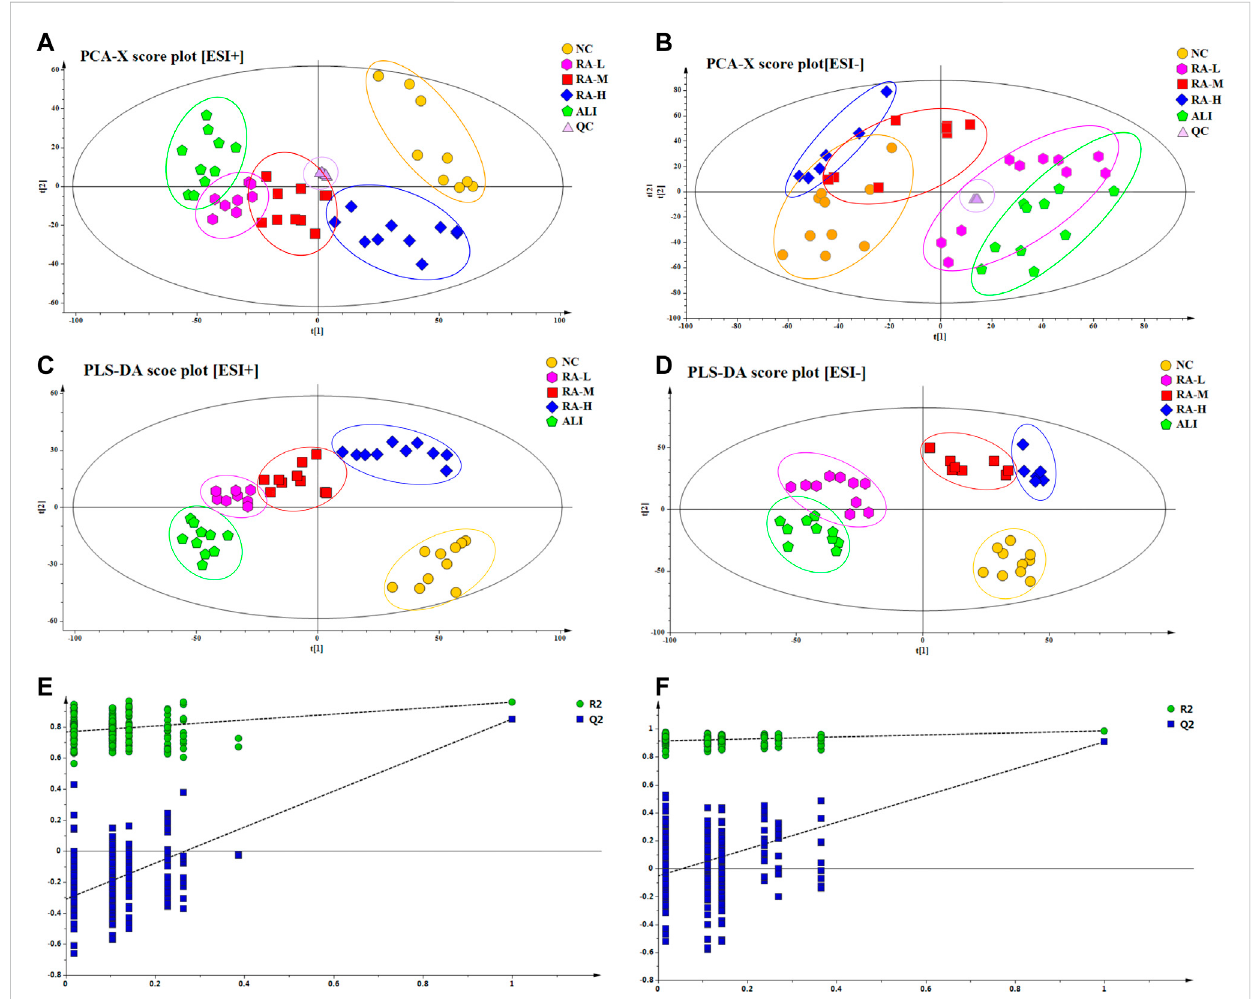
PCA score plots and PLS-DA score plots of different groups in ESI+ and ESI- mode respectively. The score plots of PCA of NC, ALI, RA-L, RA-M and RA-HgroupsfromPCAanalysisinESI+ (A) andESI- (B) ;Thescore plots ofPLS-DA ofNC,ALI,RA-L,RA-Mand RA-HgroupsfromPLS-DAanalysisinESI+ (C) and ESI- (D) ; 200-permutation test of PLS-DA model in ESI+ (E) and ESI- (F)